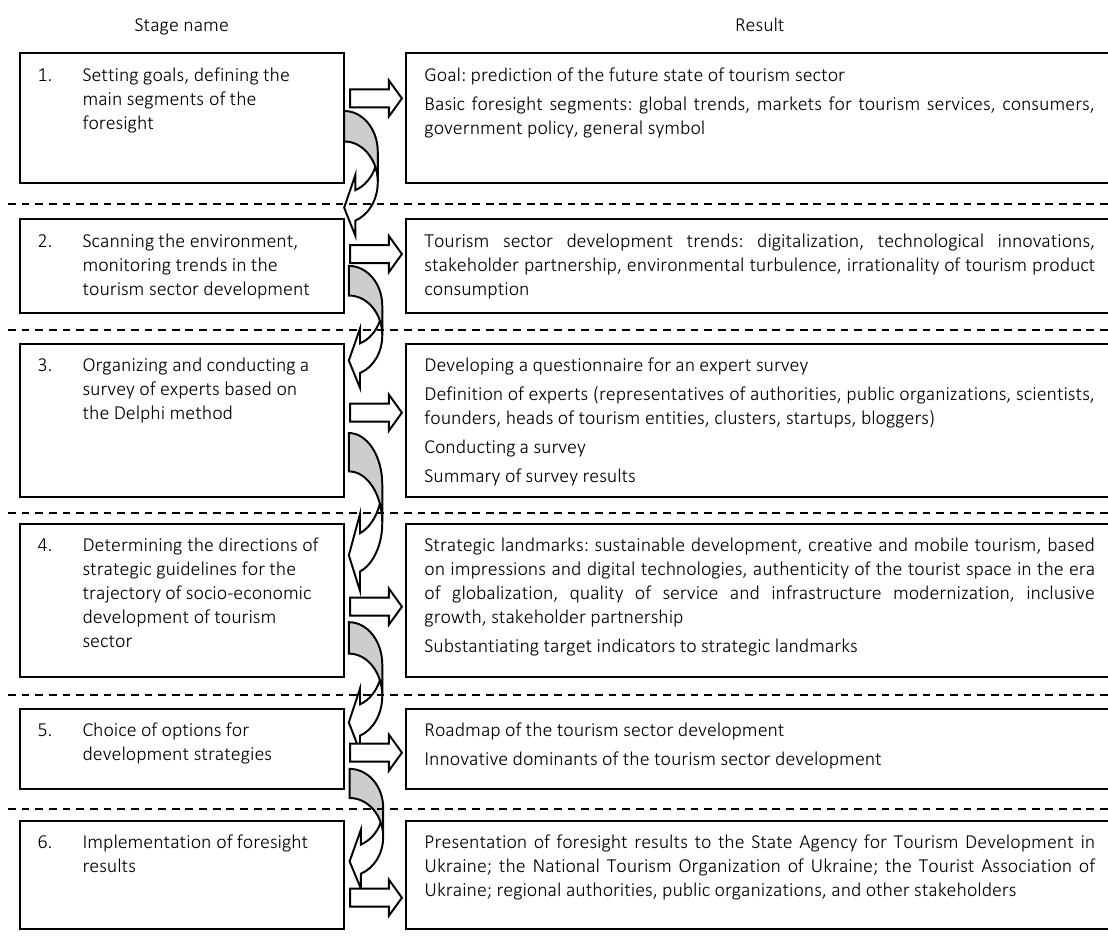
Figure 2. Structural and logical sequence of the tourism sector